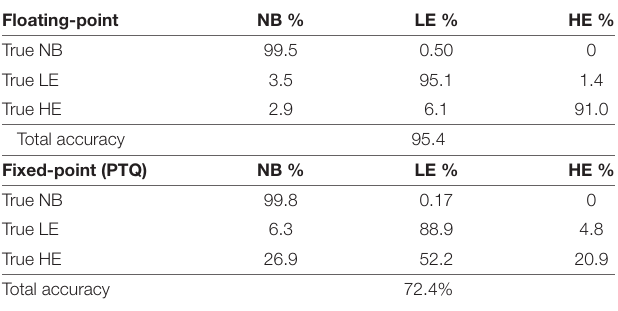
Block DSP Flip Look-up RAM units